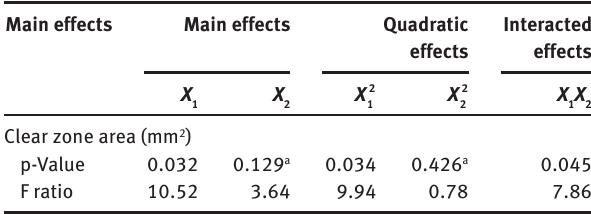
Table 3: Significance probability (p-value, F ratio) of regression coefficients in the second-order polynomial model.